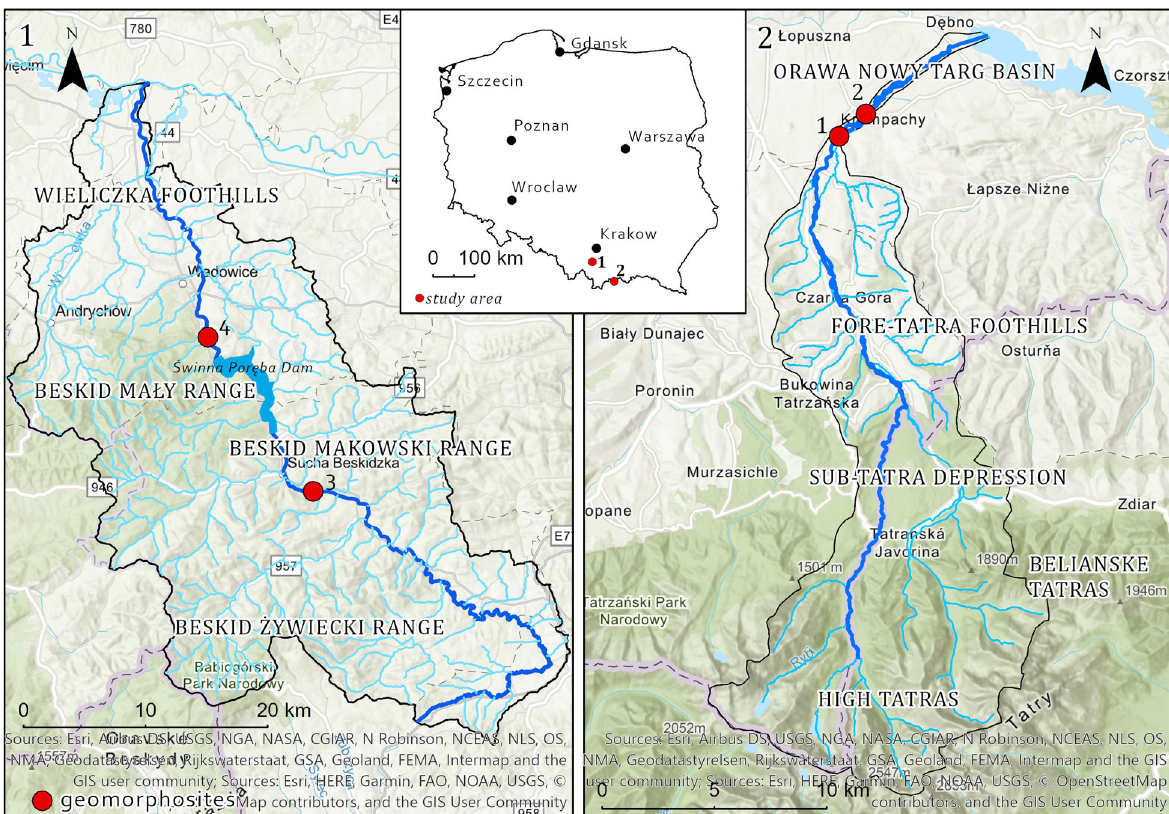
Fig. 1. The Skawa (1) and Białka (2) rivers’ catchments with the location of the geomorphosites. Based on the Hydrographical Map of Poland, available online: GUGiK